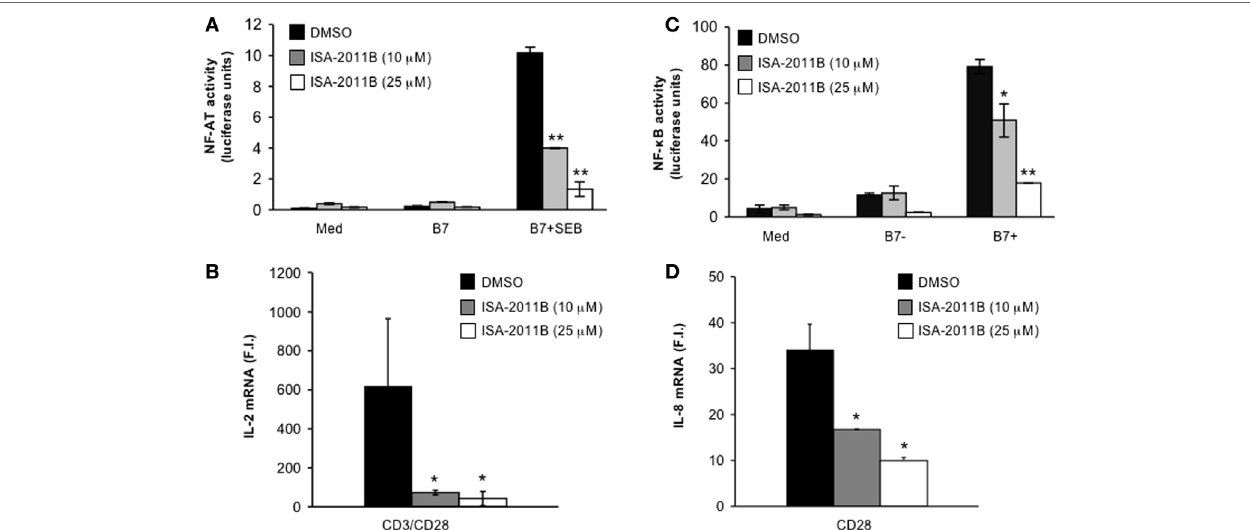
FigUre 3 | isa-2011B impairs cD28 costimulatory functions in Jurkat T cells . (a) NF-AT luciferase activity of Jurkat cells treated for 6 h with DMSO or the indicated concentration of ISA-2011B and stimulated in the absence (med) or presence of 5-3.1/B7 (B7) cells pre-pulsed or not with 1 µg/ml SEB. The results are expressed as the mean of luciferase units ± SD after normalization to GFP values. The data are representative of three independent experiments. (B,D) Real-time PCR was used to measure IL-2 mRNA (B) and IL-8 mRNA levels (D) in Jurkat cells treated with DMSO or the indicated concentration of ISA-2011B and stimulated for 6 h with control IgG or anti-CD28 Abs (D) or anti-CD3 plus anti-CD28 Abs (B) . Data are expressed as fold inductions (F.I.) over the basal level of cells stimulated with control IgG and treated with DMSO. Bars show the mean ± SD of three independent experiments. (c) NF- κ B luciferase activity of Jurkat cells treated for 6 h with DMSO or the indicated concentration of ISA-2011B and stimulated in the absence (med) or presence of B7-negative (%-3.1) or B7-positive (5-3.1/B7) cells. The results are expressed as the mean of luciferase units ± SD after normalization to GFP values. The data are representative of three independent experiments. Asterisks (*) and (**) indicate P < 0.05 and P < 0.01, respectively, calculated by Student’s t